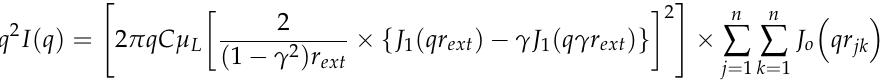
Figure 11. ( a ) Sketch of an OPV fibril, the molecule is shown as a black core with grey aliphatic arms. X is the growth direction ( b ) sketch of the crystal organization seen sideways along the Y-direction. Unlike the OPVOH molecules the OPVR molecules are tilted by an angle α = 41° ± 5°. This gives a core-to-core distance of d = 0.5 nm against d = 0.35 nm for the π - π packing in OPVOH